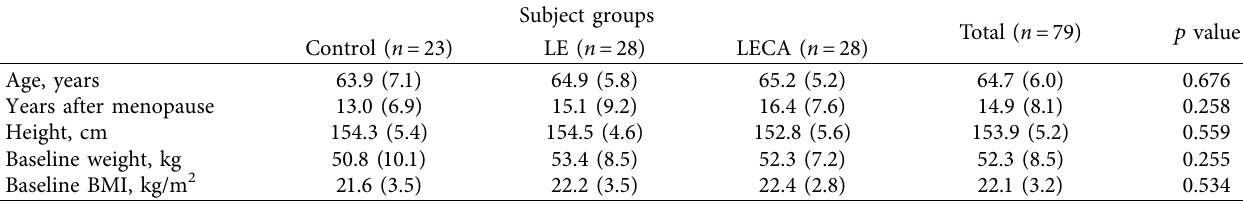
Table 2: Subject physical characteristics.